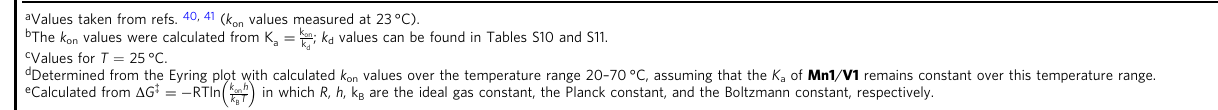
(Table 1), suggesting that ground-state effects play a signi fi cant role in lowering the activation energies for exchange when a Mn(III) ion is inserted into the porphyrin of the cage compound.